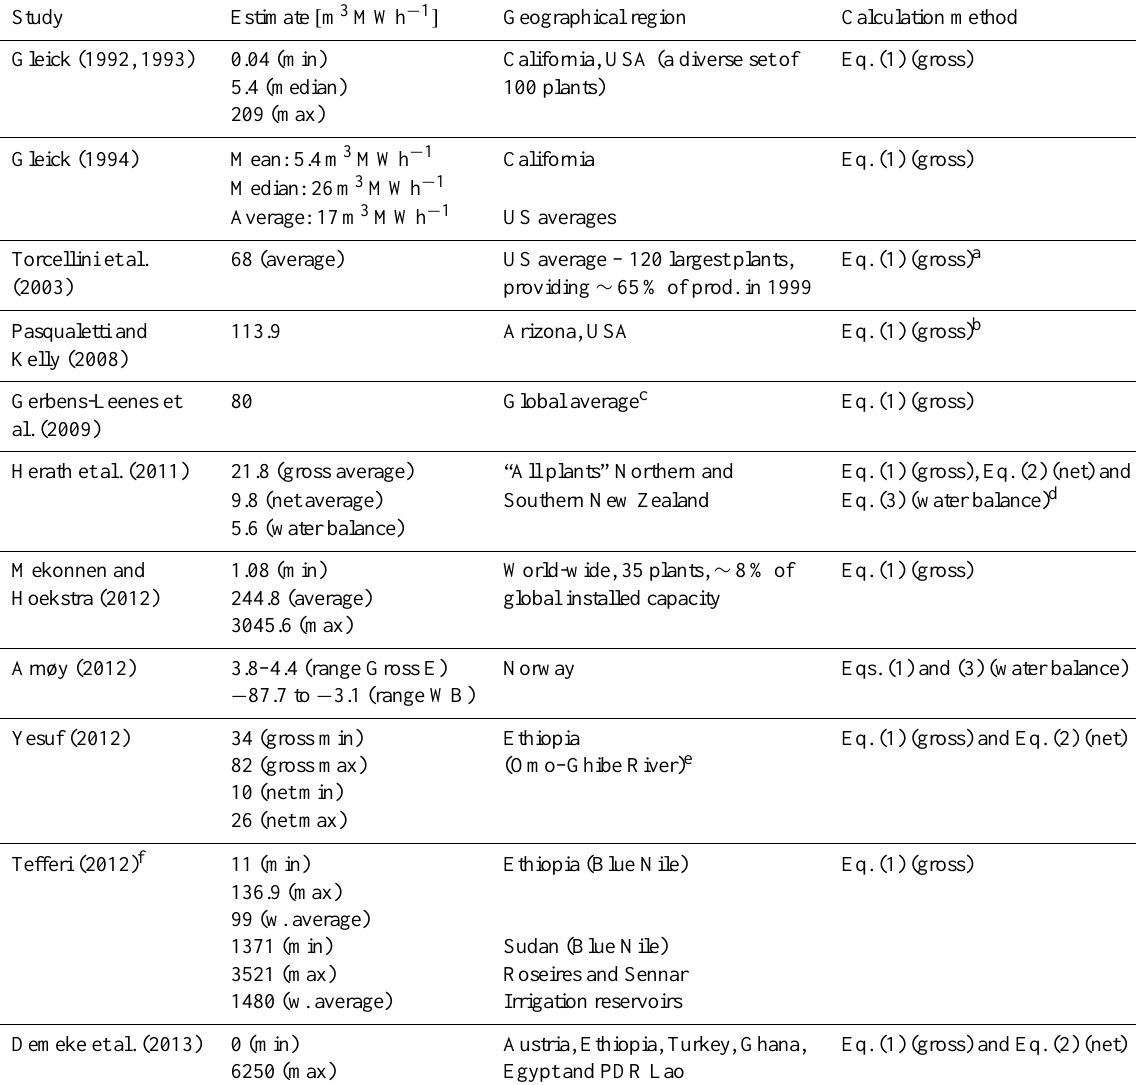
Table 1. The primary sources of water consumption estimates (adapted from Bakken et al., 2013a). In order to facilitate the comparison, the estimates are all converted into m 3 MWh − 1 from their original publications. All the publications and estimates are from primary data sources